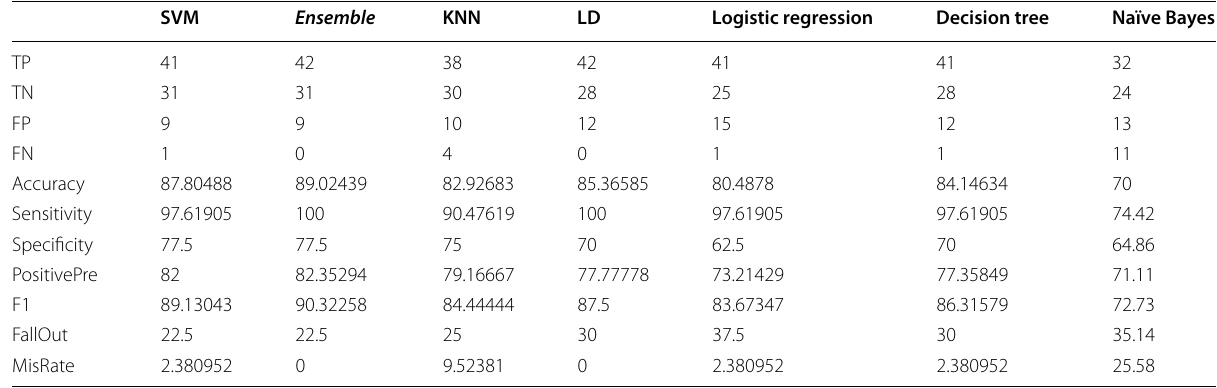
Table 7 Evaluation of the metric parameters for the seven classifiers of the continuous case testing method